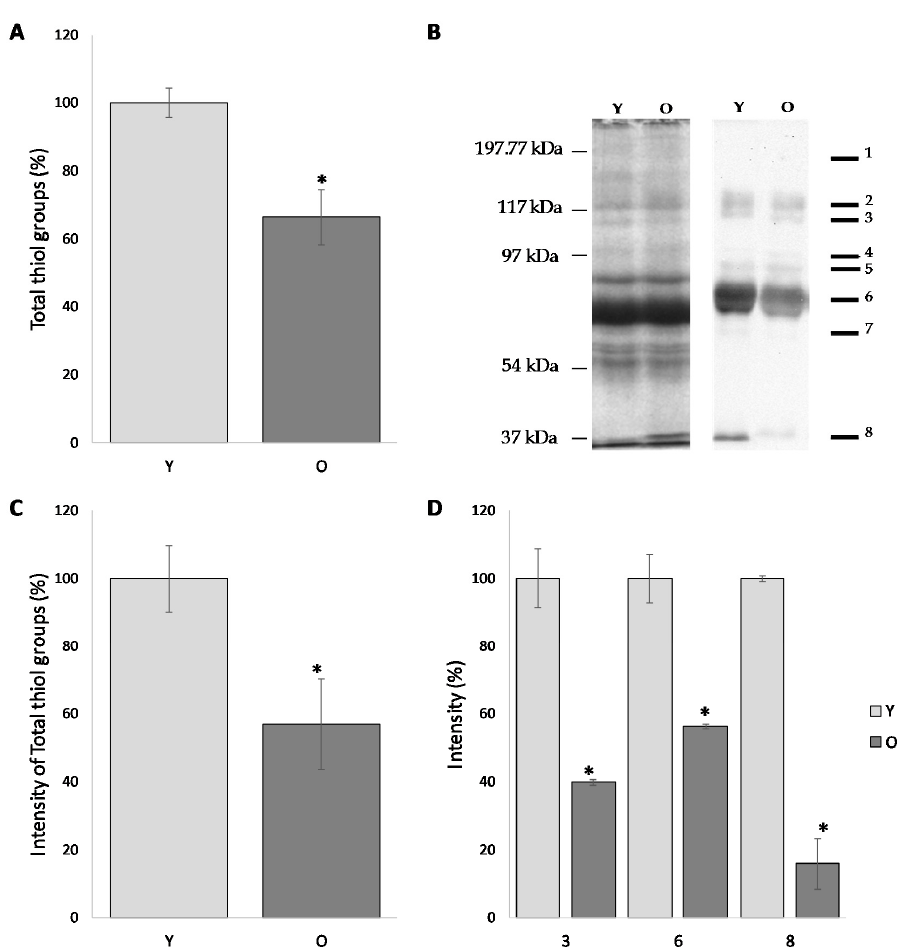
Figure 2. Total thiol groups in follicular fluids from young (Y) and old (O) women. ( A ) The level of total free –SH groups evaluated by colorimetric assay based on 5,5 ′ -dithiobis- 2-nitrobenzoic acid (DTNB) staining. ( B ) Western blot analysis of proteins from FF, stained with silver nitrate (left) or MBP (right). The 8 predominant bands (molecular weight of 190, 120, 115, 90, 80, 70, 60, and 30 kDa) are indicated. ( C ) Graph of the intensity values (pixel intensity / mm 2 ) detected by western blotting were normalized to the intensity values of the corresponding bands highlighted by the silver nitrate staining. ( D ) Relative intensities of bands 3-6-8 detected in both Y and O groups. The values were reported in percentage, considering the relative intensities of Y group as 100%. In this case the intensity of the individual bands of the spot (expressed as volume) was normalized on the intensity values of the same bands in the silver staining, in order to verify that the di ff erences in the level of SH free observed were not due to the di ff erential expression of the protein but of di ff erences in the level of post-translational modification. * p <